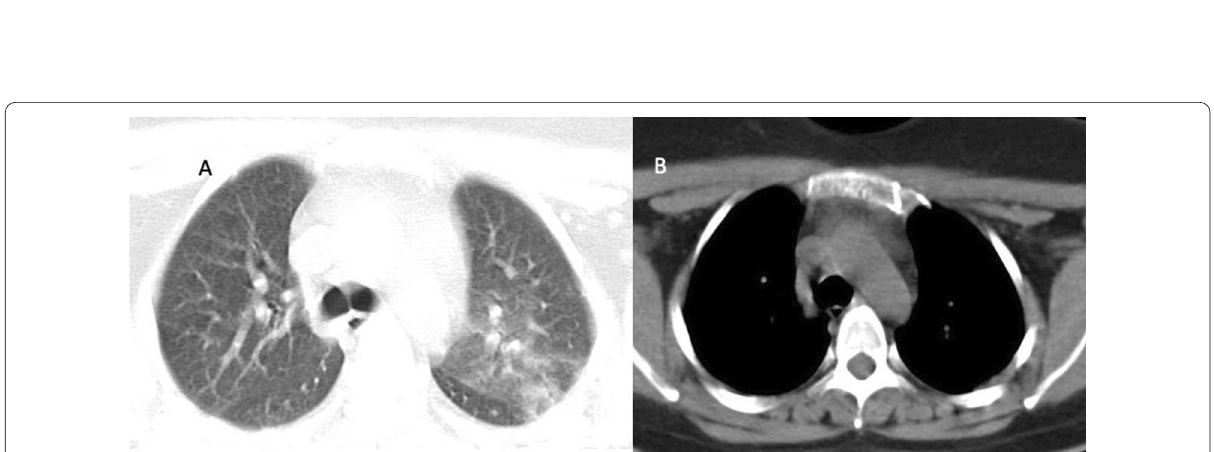
Fig. 2 29-year-old female COVID-19(